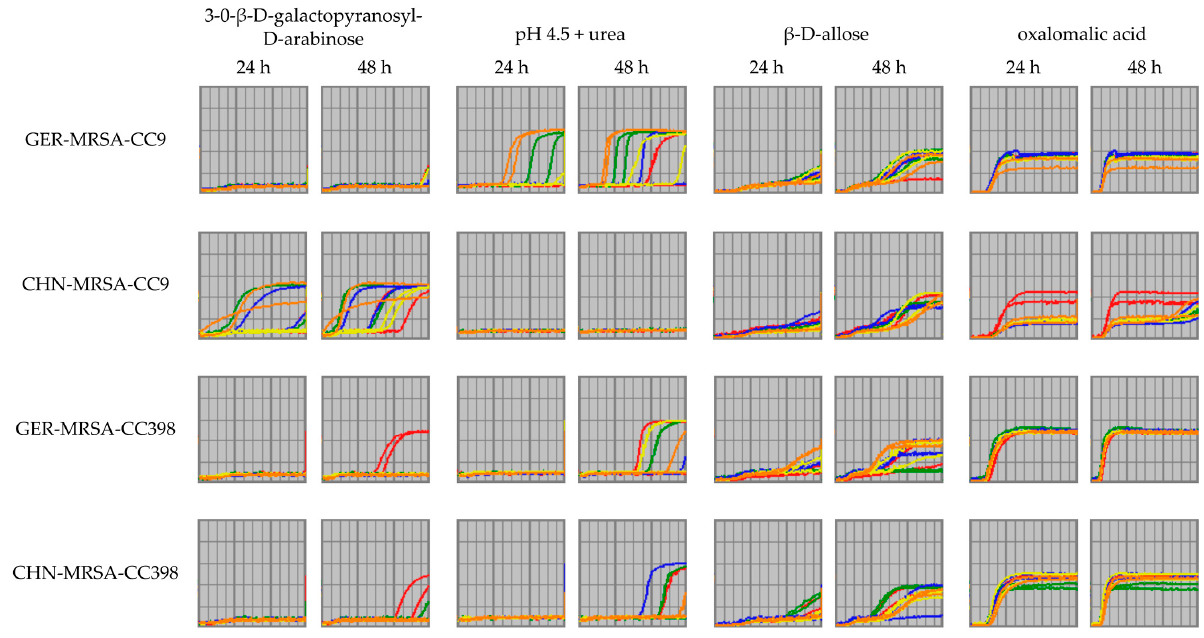
Figure 8. Curves displaying cellular respiration of the four isolate groups in the presence of 3-0- β -D-galactopyranosyl-D-arabinose, pH 4.5 + urea, β -D-allose and oxalomalic acid over an incubation period of 24 h and 48 h including two test runs. The isolates within each group are indicated in different colors. Here, interesting changes in curve progression are only detectable by investigating the 48 h respiration curves additionally.